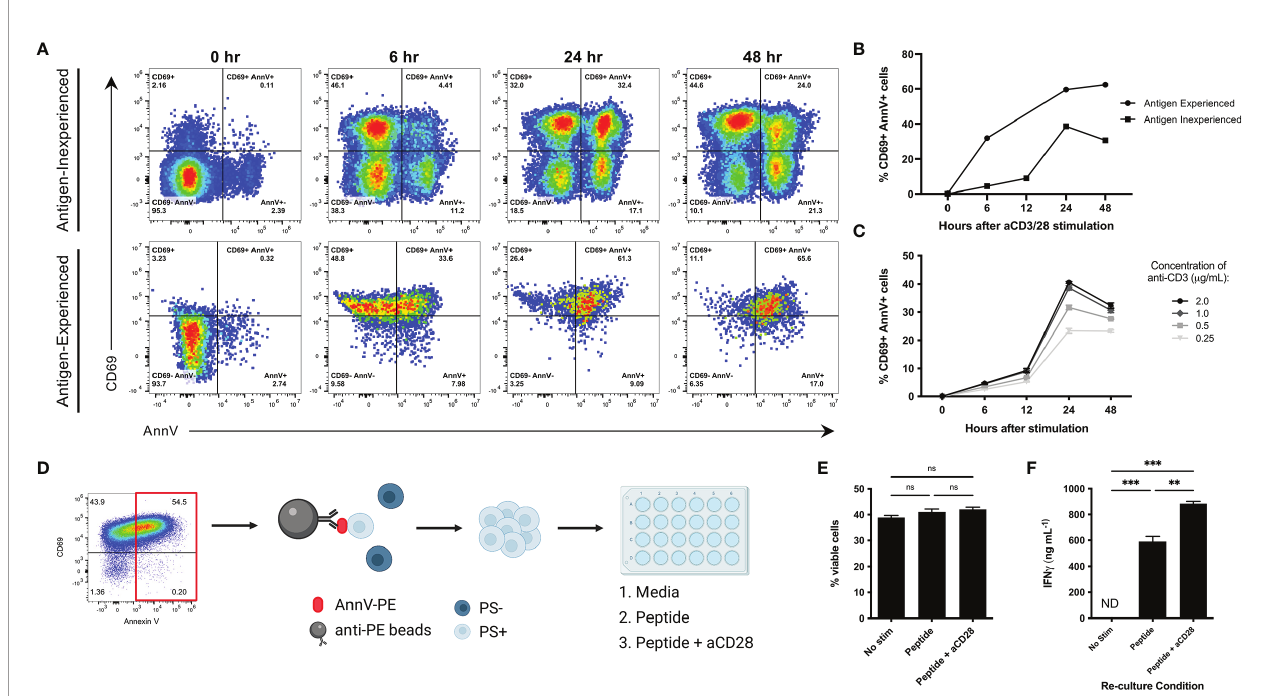
FIGURE 1 | Characterization of transient externalization of phosphatidylserine in activated T cells. (A, B) Antigen inexperienced or antigen experienced CD8+ cells were cultured with anti-CD3 and anti- CD28 (antigen inexperienced cells only) and stained with CD69 and AnnV at the indicated time points. Live and activated CD8+ cells were gated on forward scatter and side scatter pro fi les. Representative dot plots from one sample are shown. (C) Frequency of CD69+ AnnV+ cells at the indicated time points for antigen inexperienced CD8+ T cells stimulated with the indicated concentrations of anti-CD3. (D) Schematic of experiment work fl ow. (E) Frequency of viable cells after 3 days of re-culture was quanti fi ed by fl ow cytometry. (F) ELISA for IFN g in culture supernatant. Data is represented by mean ± SEM. P values were calculated by ordinary one-way ANOVA with the Tukey-Kramer multiple comparison test, and P < 0.05 is considered statistically signi fi cant. ** = < 0.01,*** = < 0.001. AnnV, Annexin V. NS, not signi fi cant. Schematic in 1D was generated using